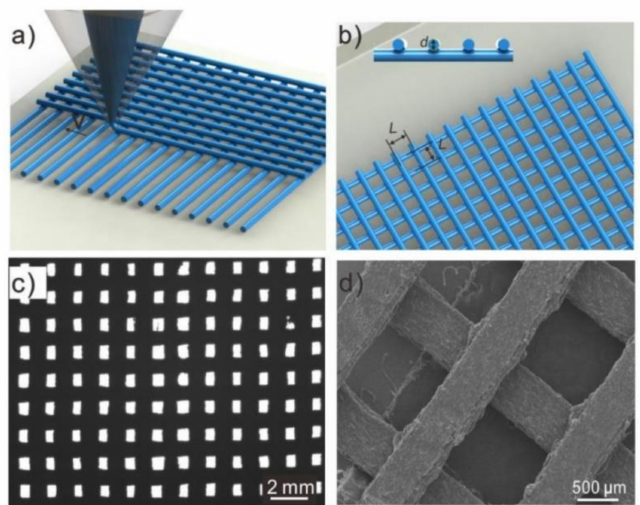
Figure 25. ( a ) Typical schematic illustration of the fused deposition modeling (FDM) 3D printing process. ( b ) Design of 3D printing orthogonal mesh with parameter of diameter, layers, and spacing. ( c , d ) Optical and SEM photographs of Fe/PLA composites mesh with through-hole (Reproduced with permission from Reference [180], copyright 2019,